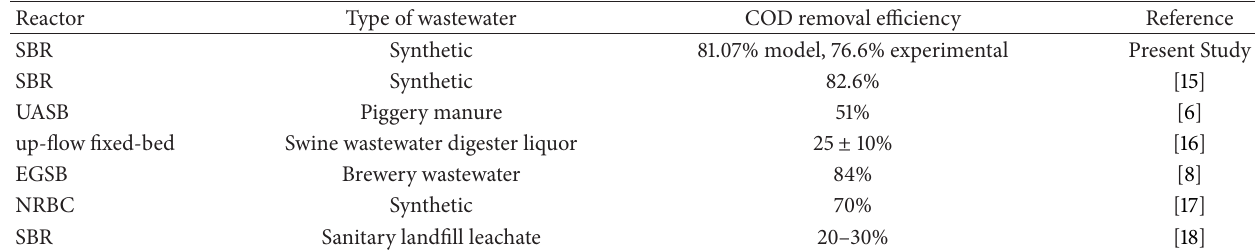
Table 7: Performed studies of COD removal using the ANAMMOX